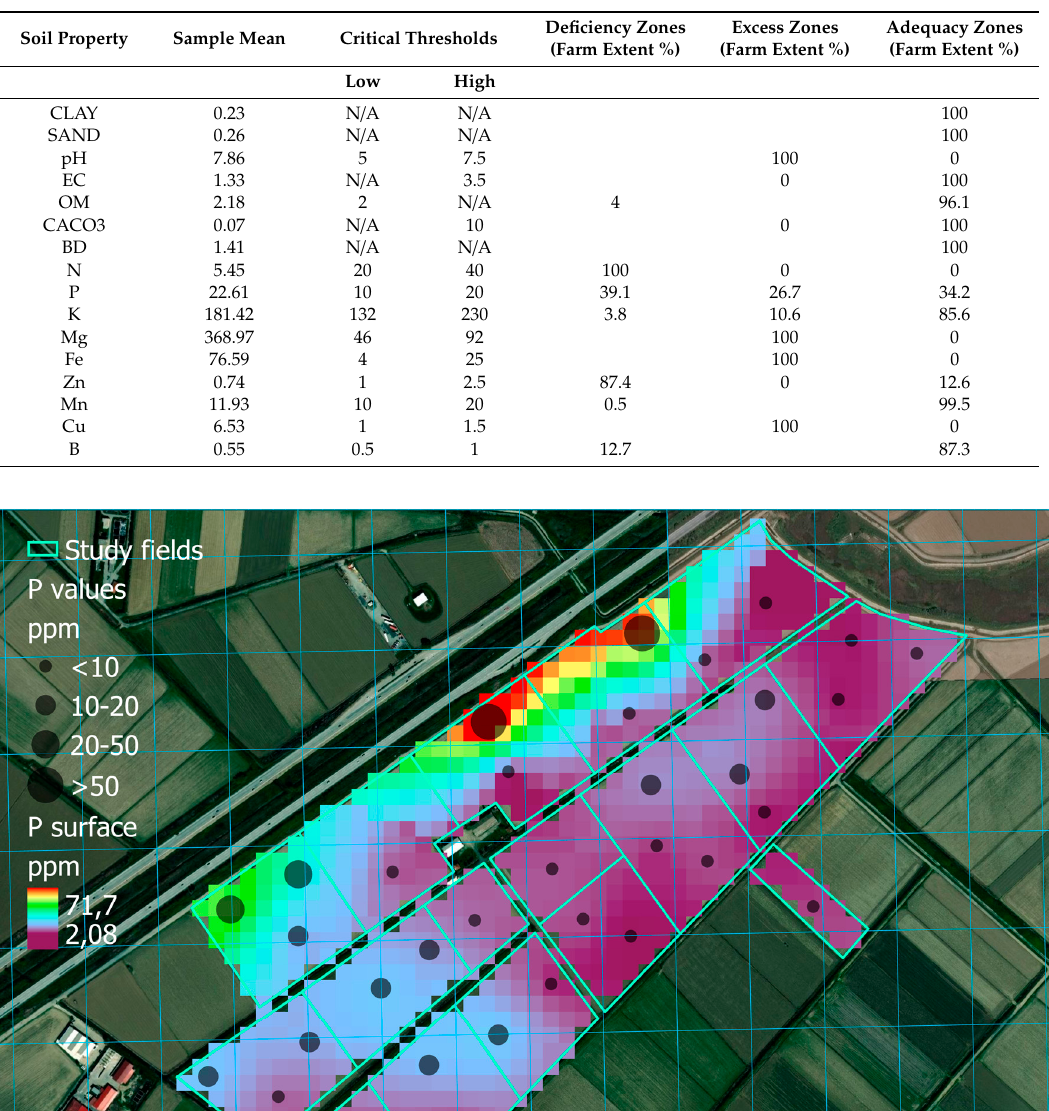
Table 4. Soil properties, their critical thresholds for rice cultivation, and related farm extents.